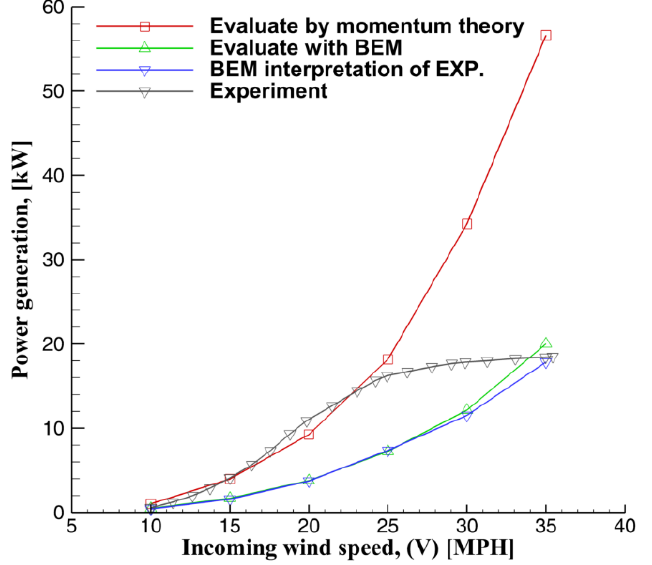
Figure 7. The power generation of a rotor under steady driving wind speed. The experiment curve was plotted using the data of Alder, Henton, and King